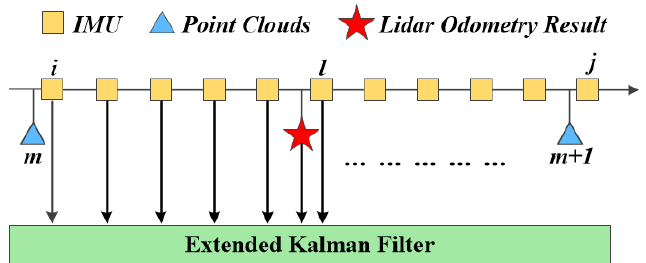
Figure 5. The diagram of the proposed fusion framework. The yellow rectangle represents the IMU data, and the blue triangle indicates the lidar point clouds. The red star denotes the localization result output from the lidar